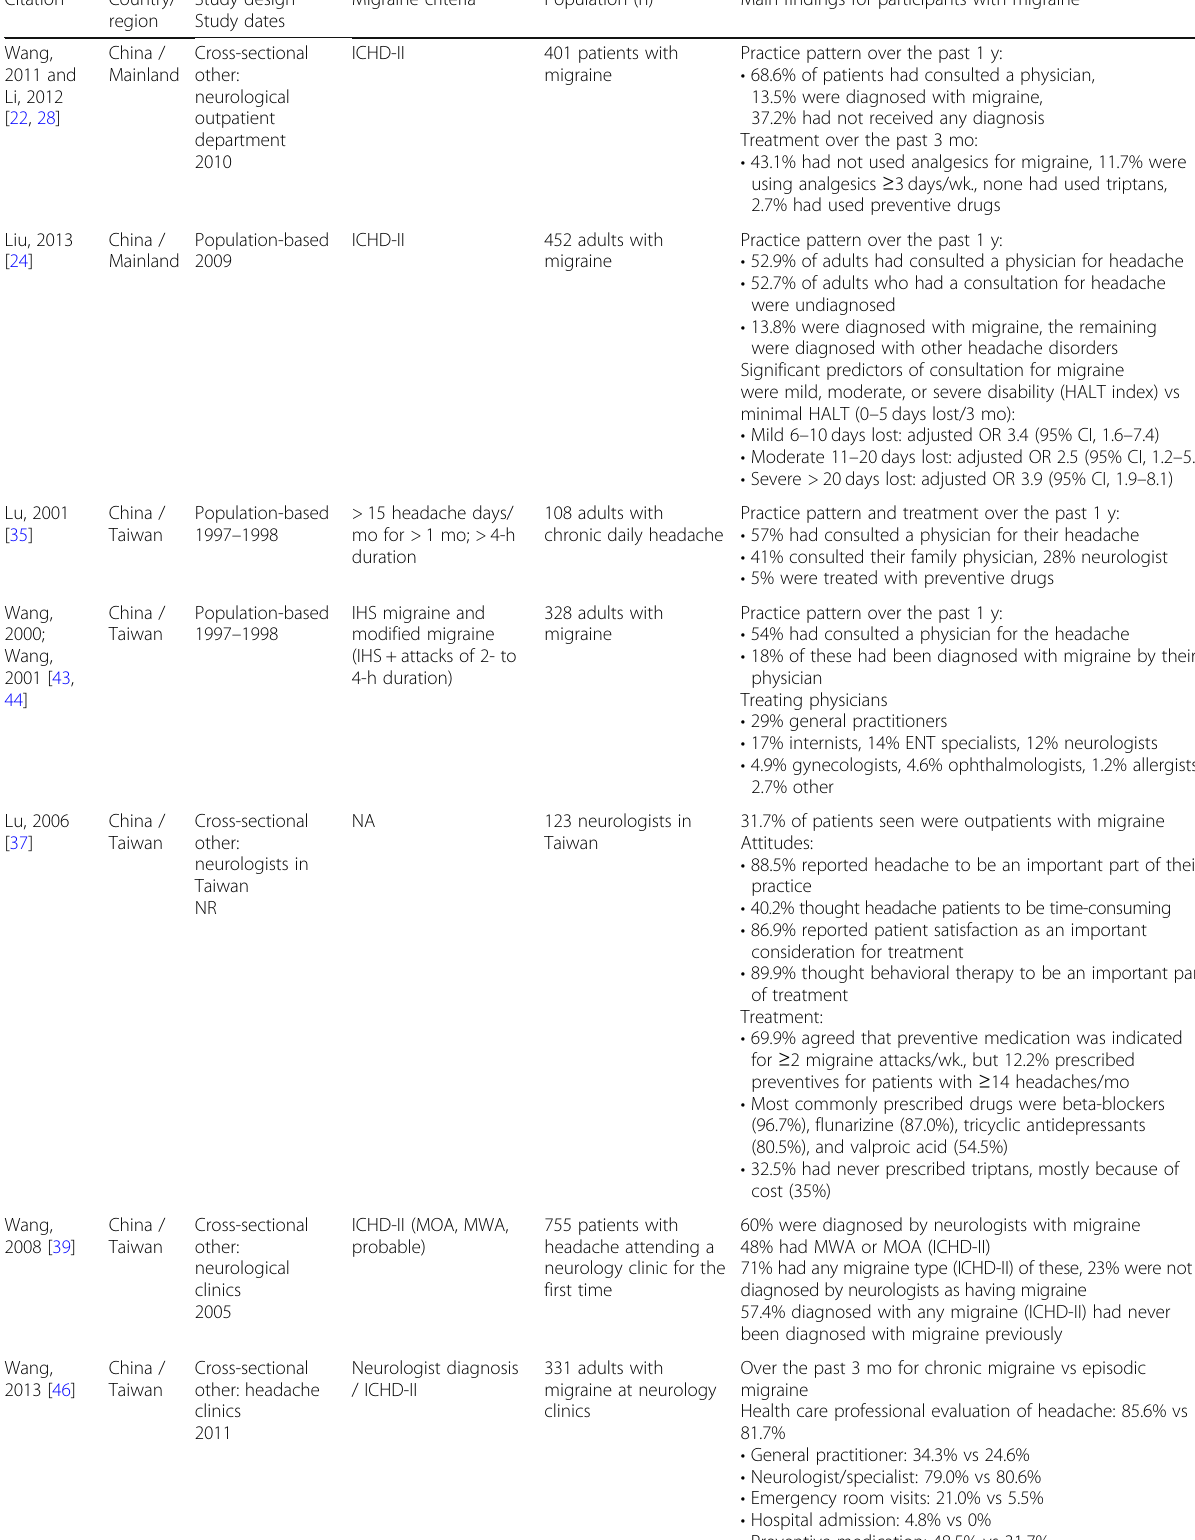
Table 3 Studies reporting clinical management of migraine